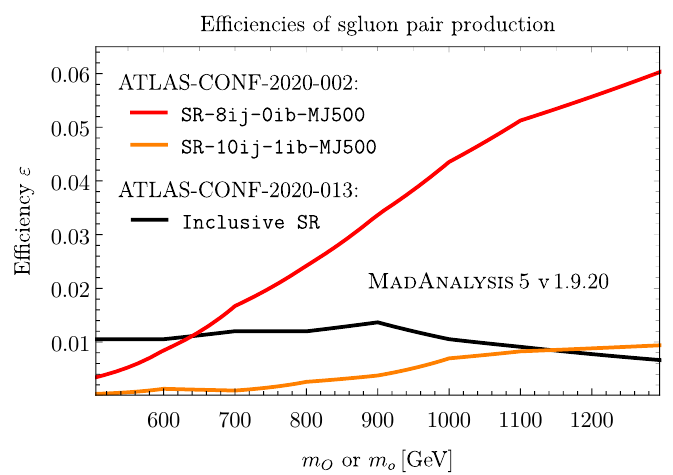
Figure 7 . Efficiencies of event samples of scalar or pseudoscalar sgluon pair production followed by decays to t ¯ t pairs under relevant signal regions in ATLAS-CONF-2020-002 and ATLAS-CONF-2020- 013. Efficiencies hover around 1% in the inclusive SR for ATLAS-CONF-2020-013, the measurement of σ ( pp → t ¯ tt ¯ t ) , and rise with increasing sgluon mass for both displayed SRs of ATLAS-CONF- 2020-002, the search for new